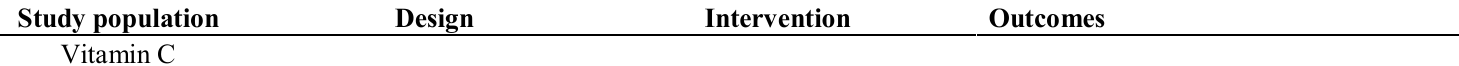
Table 3. Intervention studies assessing antioxidant supplementation on asthma outcomes in adults with